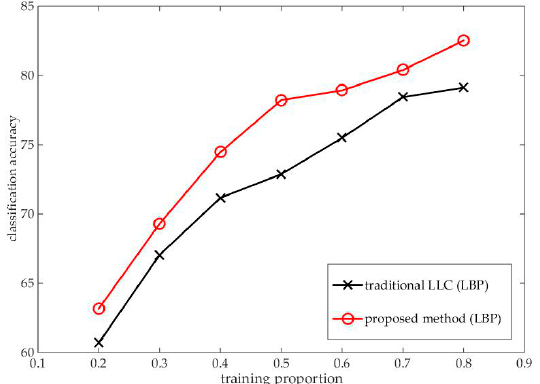
Figure 9. Different ratios of training set experiments based on LBP.